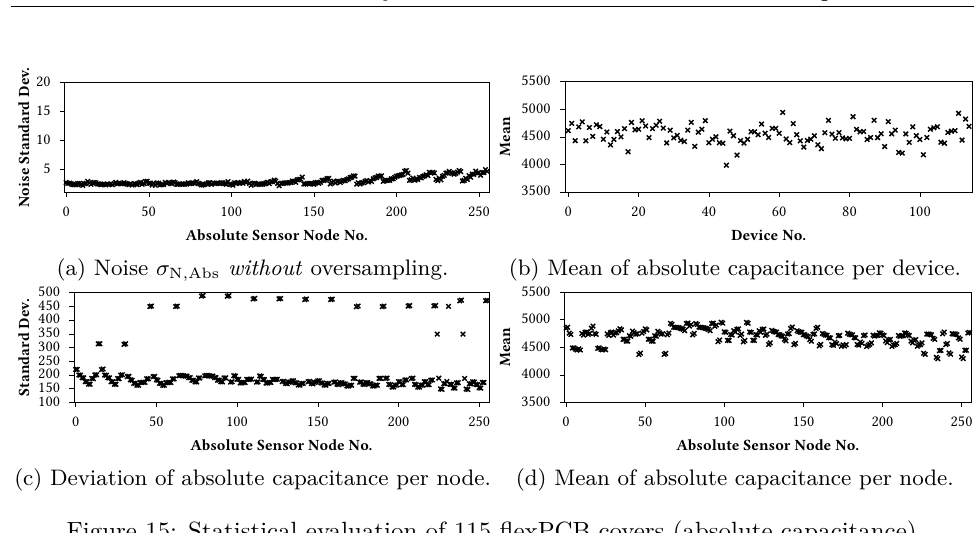
Figure 15: Statistical evaluation of 115 flexPCB covers (absolute